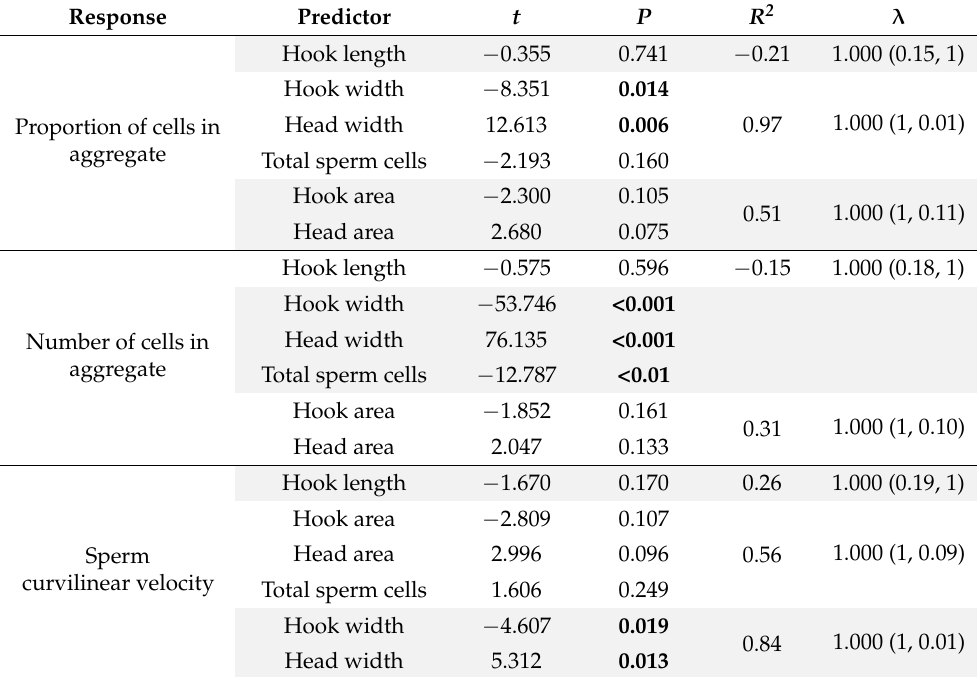
Table 2. Results from phylogenetic generalized least-squares regression models explaining sperm behavior-based hook